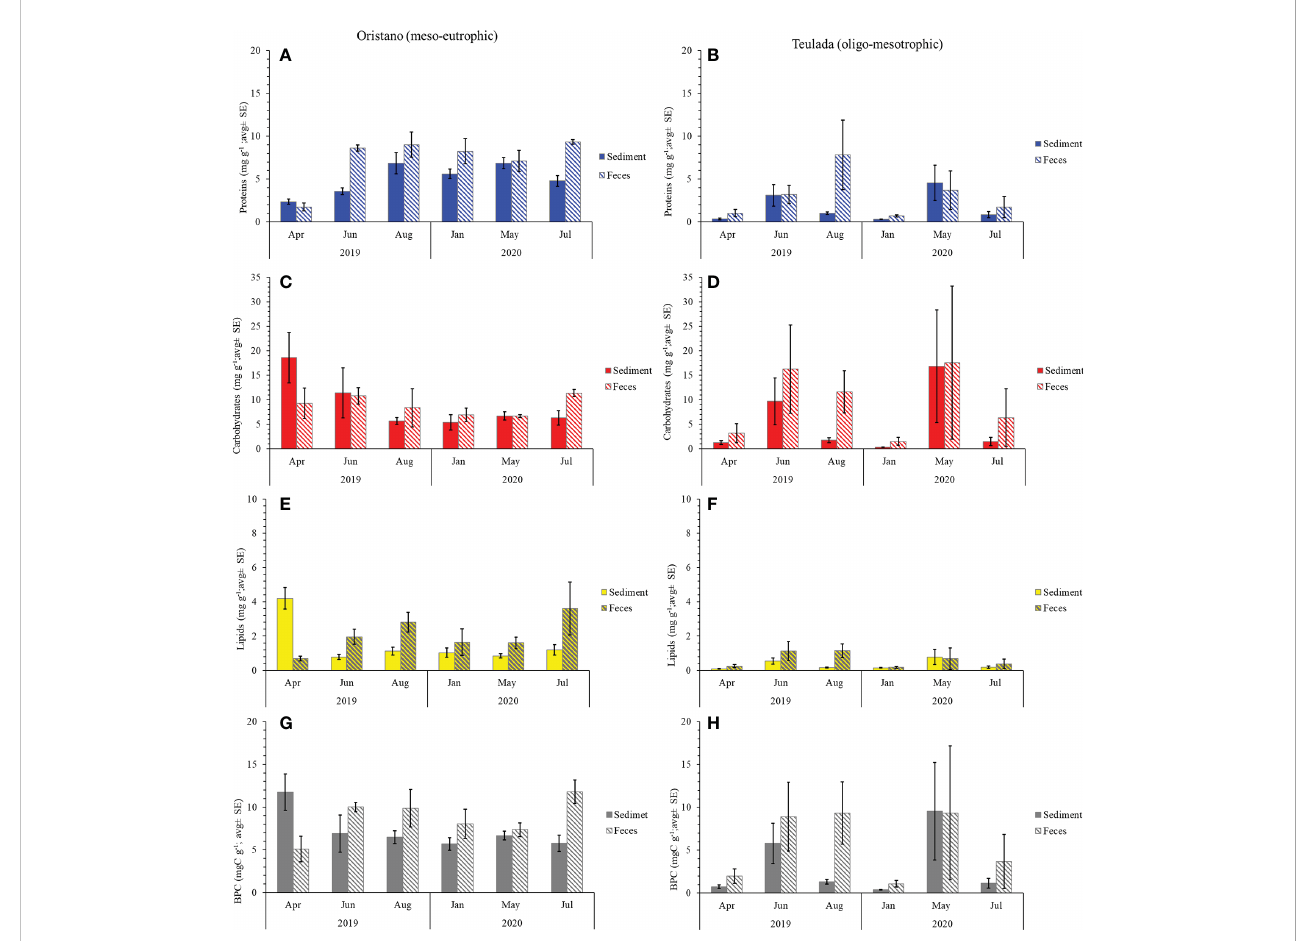
Proteins Lipids Biopolymeric C (BPC)